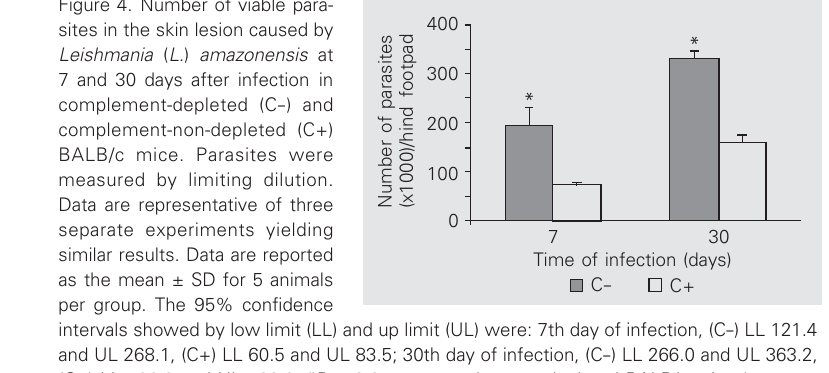
4. Number of viable para- sites in the skin lesion caused by Leishmania ( L. ) amazonensis at 7 and 30 days after infection in complement-depleted (C-) and complement-non-depleted (C+) BALB/c mice. Parasites were measured by limiting dilution. Data are representative of three separate experiments yielding similar results. Data are reported as the mean ± SD for 5 animals per group. The 95% confidence intervals showed by low limit (LL) and up limit (UL) were: 7th day of infection, (C-) LL 121.4 and UL 268.1, (C+) LL 60.5 and UL 83.5; 30th day of infection, (C-) LL 266.0 and UL 363.2, (C+) LL 126.9 and UL 190.9. *P < 0.05 compared to non-depleted BALB/c mice (one-way